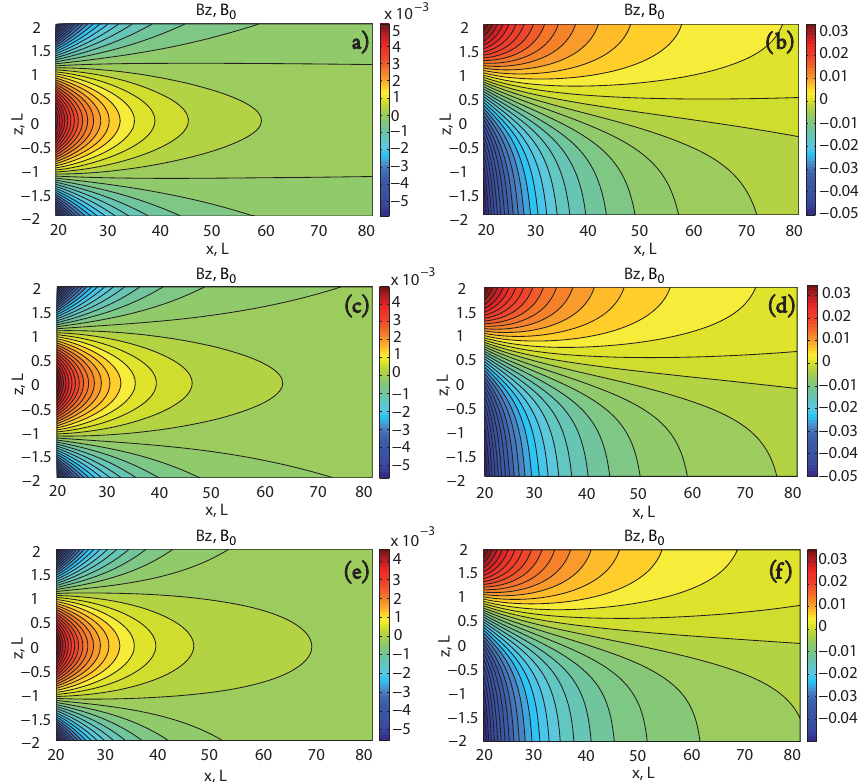
Figure 9. Magnetic field component B z (x,z) by an analytical model (Eqs. 11–16) for { a 1 = 0 , a 2 = − 0 . 03 , b = 22 . 13 , f = 0 , k = 1 } is shown for three values of the parameter n for plane sheets ( a , c , e , ϕ = 0) and curved sheets ( b , d , f , ϕ = 60). In panels (a, b) , n = 0 . 995. In (c, d) , n = 1. In (e, f) n = 1 . 005. Panel (c) corresponds to the plane substorm sheet (see Fig. 4c). Units are normalized for CS typical width L and B 0